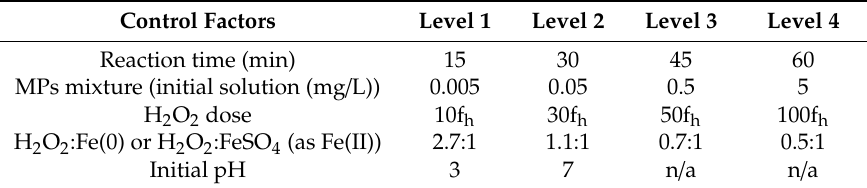
Table 2. Chosen levels of each control